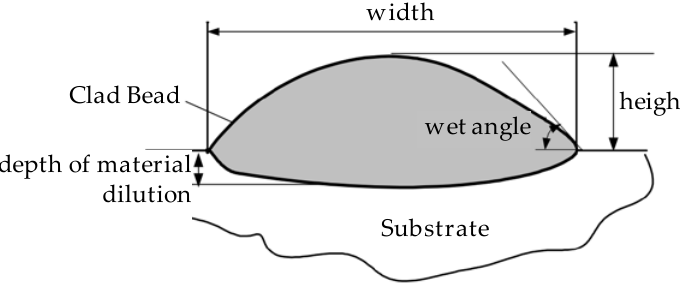
Figure 2. Clad cross section parameters.